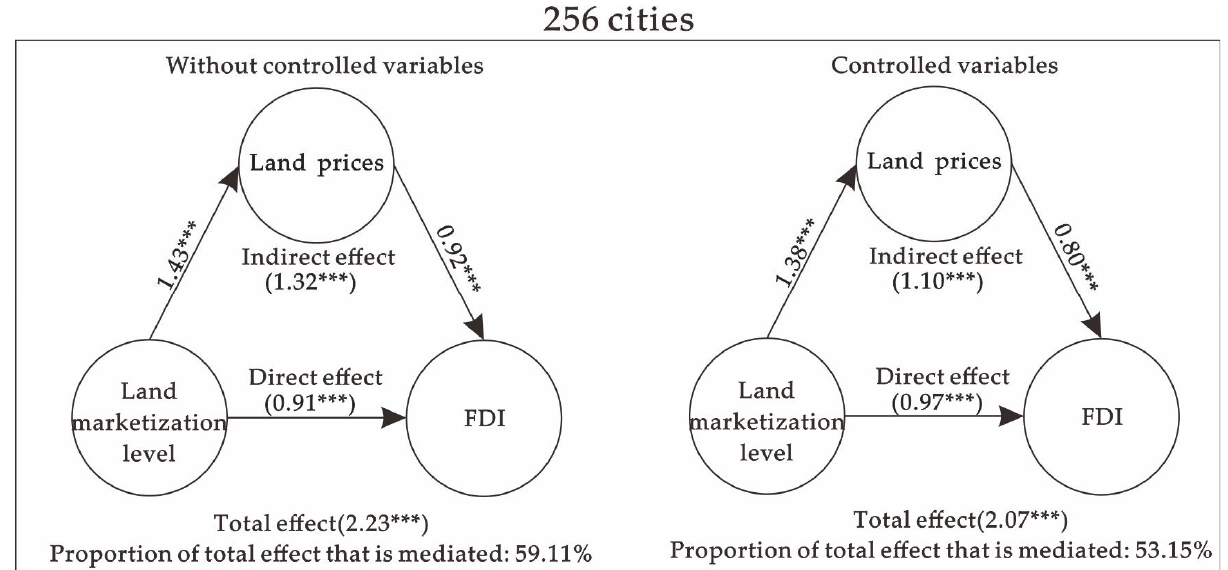
Figure 6. Effects of land marketization level and land prices on FDI in 256 cities. Note: *** p < 0.01.